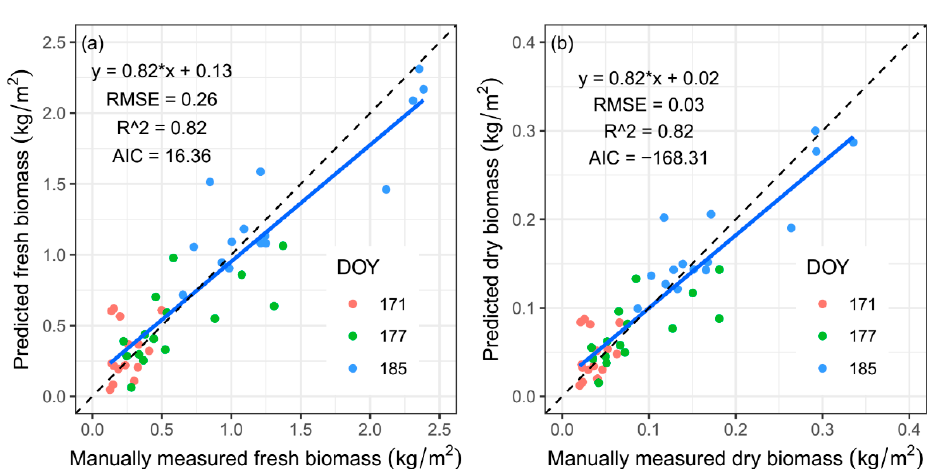
Figure 8. Correlations between maize above-ground biomass estimated based on NGRDI, ExGR, and VEG by using multivariable linear regression analysis and ground-truth above-ground biomass; ( a ) and ( b ) were maize fresh and dry above-ground biomass, respectively.